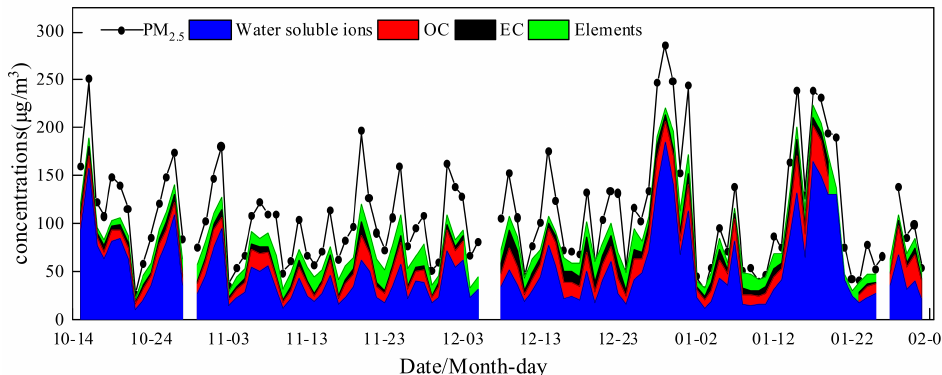
Figure 3. Concentration of chemical components of PM 2.5 during the sampling period in